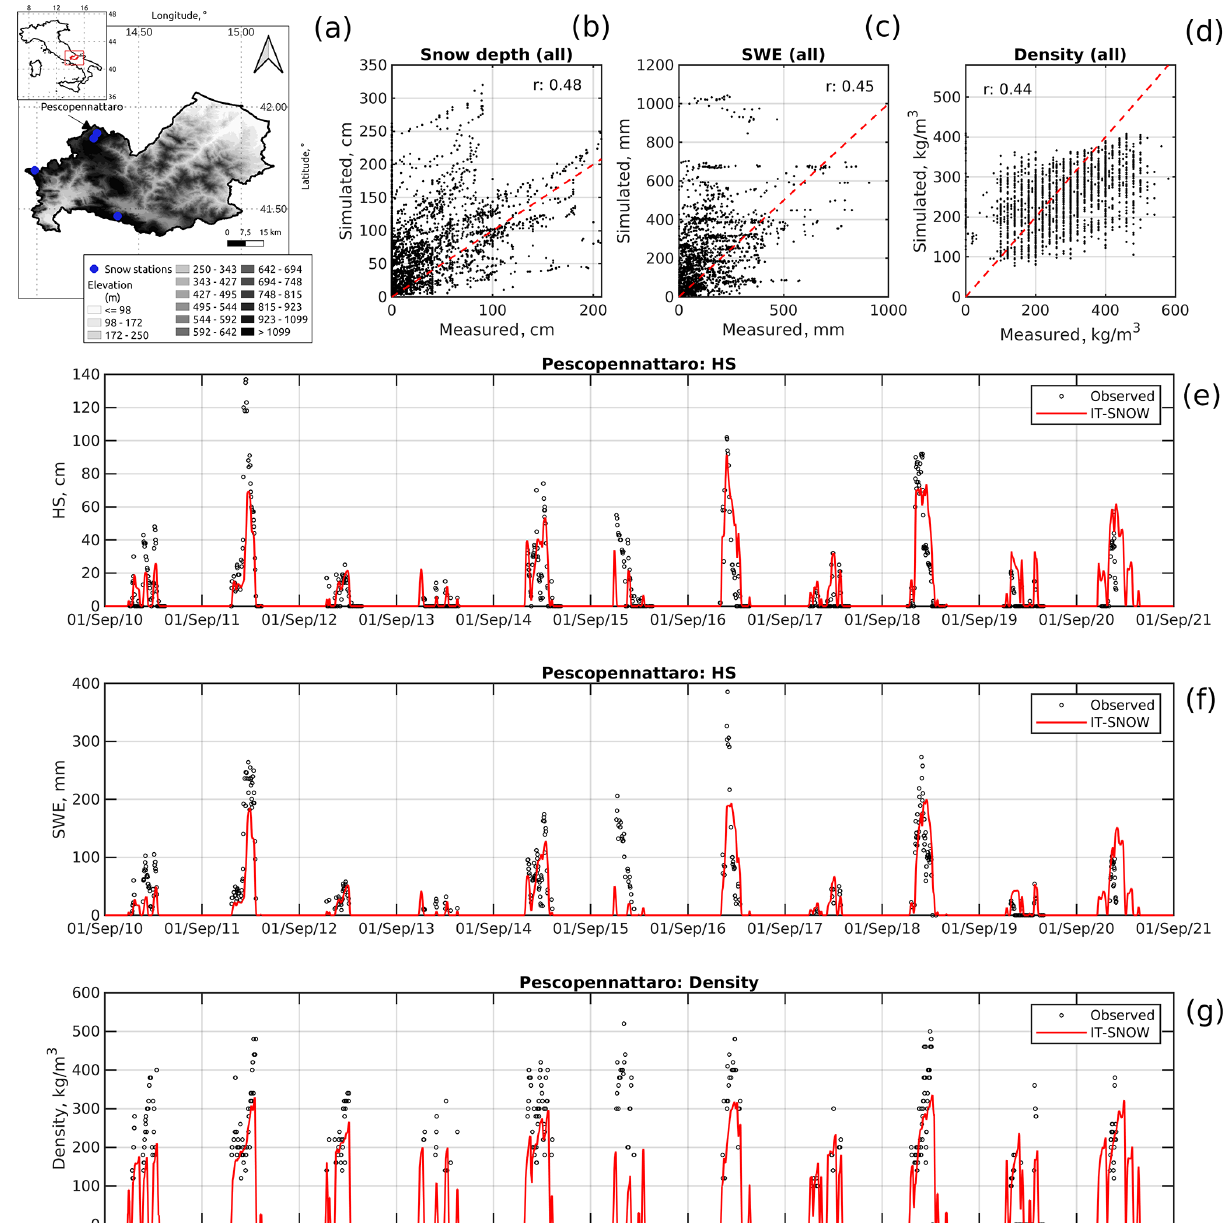
Figure 8. Evaluation of IT-SNOW in Molise. (a) Topography of the focus region, along with sampling location of evaluation data. (b– d) Simulated vs. observed snow depth, SWE, and bulk snow density at Molise snow stations, respectively. (e–g) Example of simulated vs. observed time series of snow depth, SWE, and bulk snow density at Pescopennataro, respectively. Note that simulated snow depth, SWE, and density in panels (e–g) were smoothed using a 5d moving window for readability. r is Pearson’s correlation coefficient, HS is snow depth, and SWE is snow water equivalent. Density was measured with a resolution of 20kgm − 3 ; hence, the discrete values of the point cloud along the x axis are shown in panel (d)